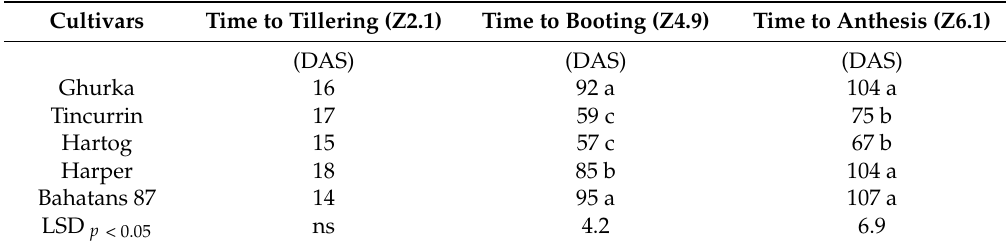
Table 2. Time in days after sowing (DAS) to the onset of tillering (Z2.1) measured in five wheat cultivars grown in rhizoboxes, and to booting (Z4.9) and anthesis (Z6.1) measured in the same cultivars